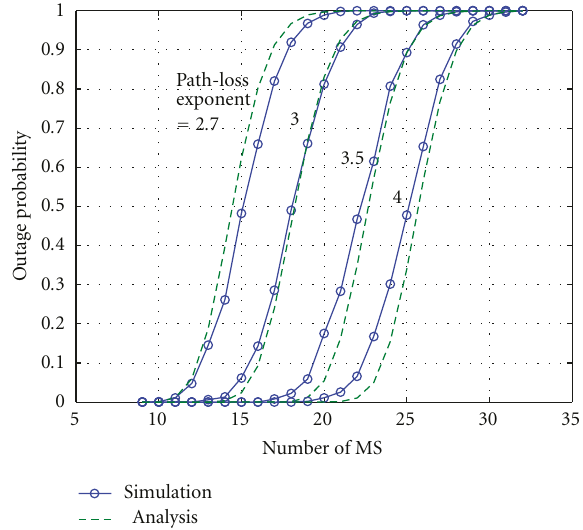
Figure 9: Global outage probability as a function of the number of MS per cell and for path-loss exponents η = 2 . 7, 3 . 5, and 4, simulation and analysis.